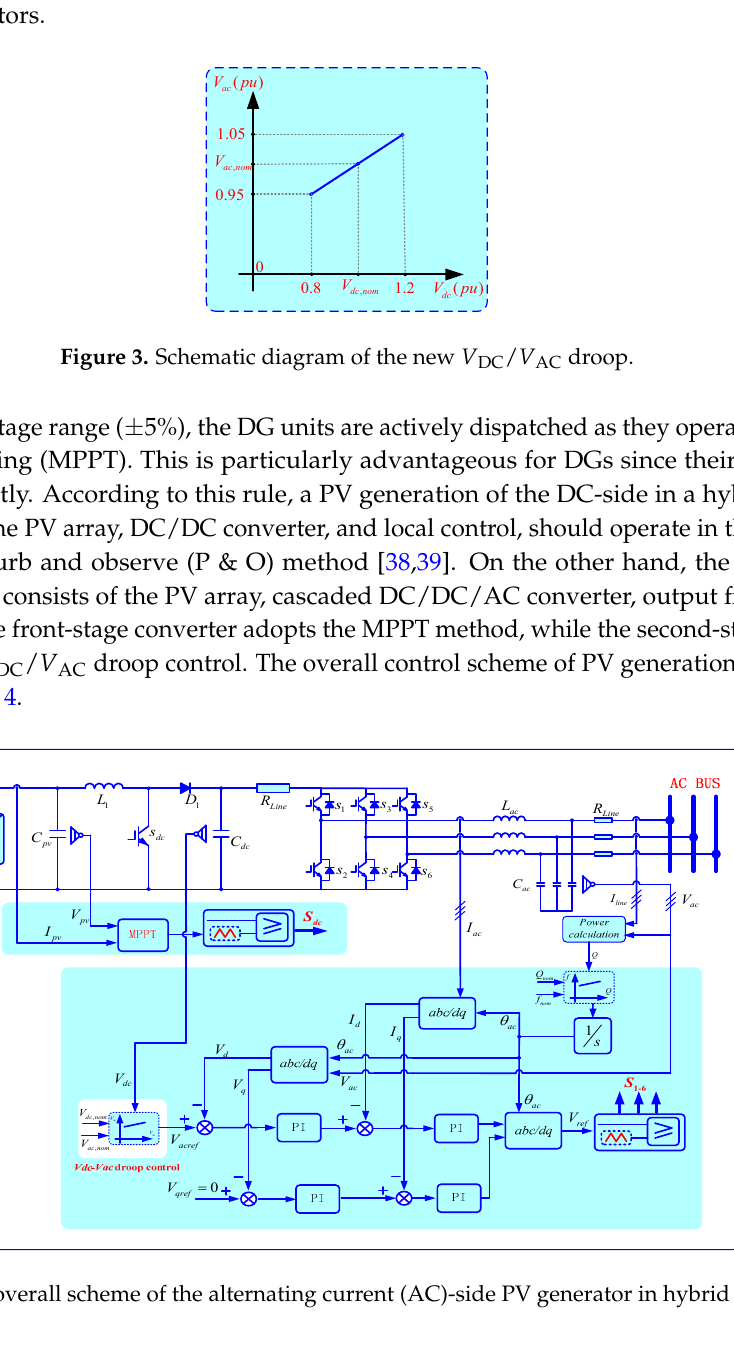
Figure 4. The overall scheme of the alternating current (AC) ‐ side PV generator in hybrid microgrid.